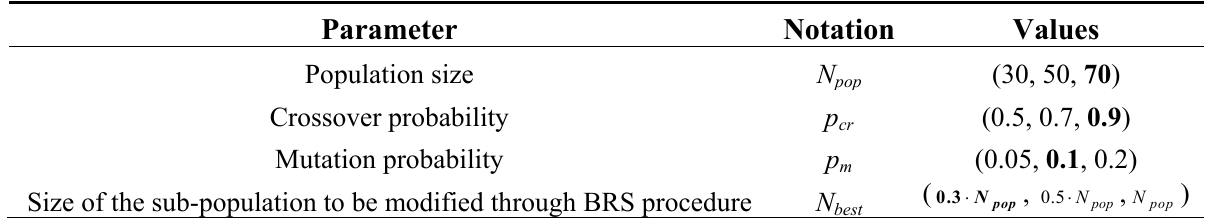
Table 6. Genetic Algorithm with Random Sampling GARS experimental